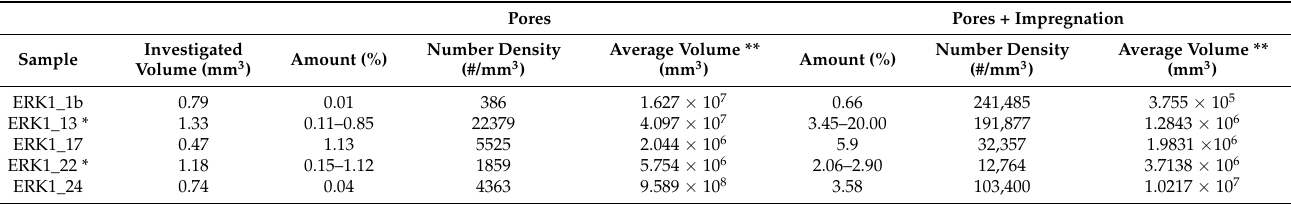
Table 2. Results of quantitative analysis on 3D images from a selection of representative specimens.